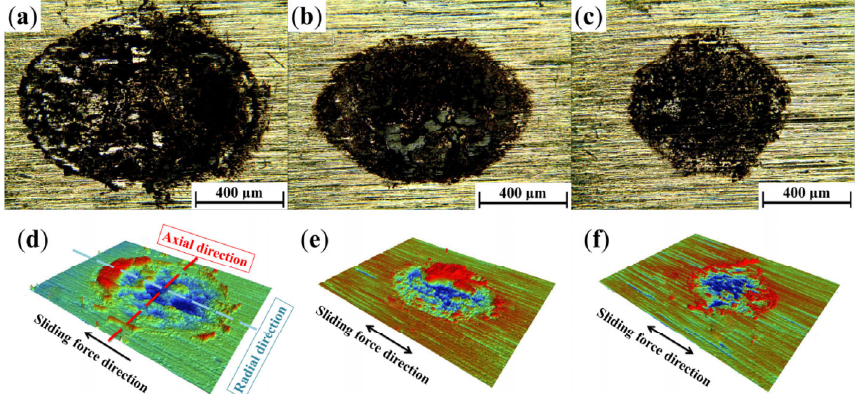
Fig. 13 OM and 3D micrographs of tube wear scars under different complex motions. (a, d) Unidirectional, (b, e) reciprocating, and (c, f) multi-mode